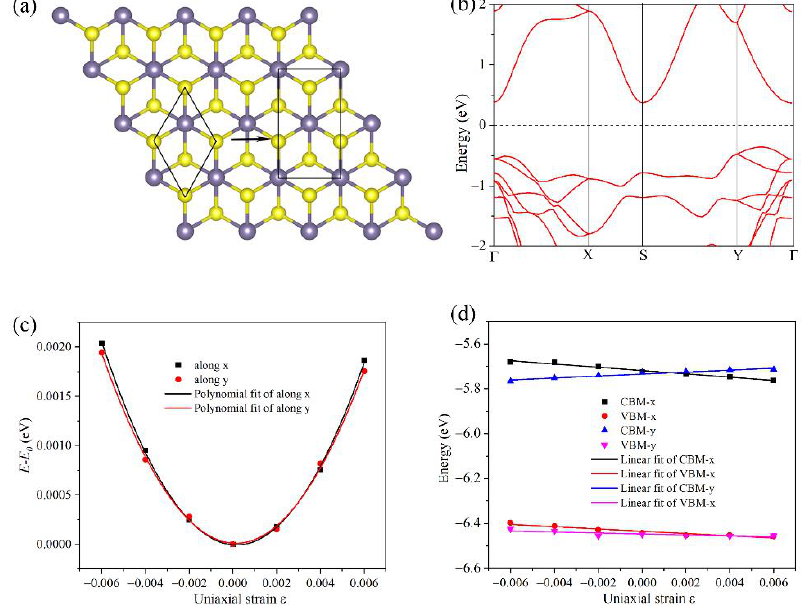
Figure 10. ( a ) The orthorhombic lattice of GeS 2 monolayer. The calculated ( b ) electronic band structure, ( c ) total energy shift, and ( d ) band alignment for orthorhombic lattice GeS 2 monolayer with respect to the uniaxial strain ε by PBE functional. Table 1. Calculated deformation potentials ( E l ), effective mass ( m *), elastic modulid ( C 2D ), carrier mobility ( μ ), and electronic relaxation time ( τ ) of GeS 2 monolayer under different directions.